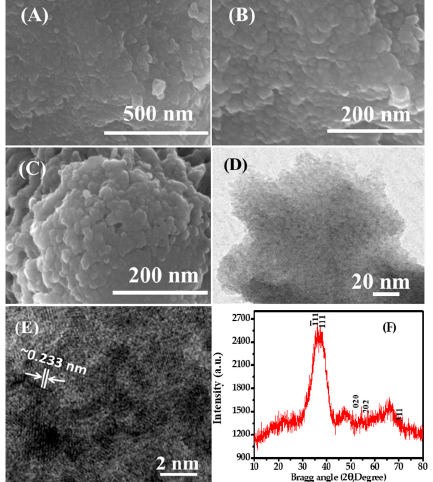
Figure 1. Field emission scanning electron microscopy (FE-SEM) images of copper oxide nanoparticles (CuO NPs): ( A ) NPs at low magnification and ( B ) high magnification; ( C ) After the adsorption of NPs; ( D ) TEM images of CuO NPs at low magnification; ( E ) HR-TEM images of NPs with lattice fringes about ~0.233 nm apart and showing the “d” value of the (111) of CuO NPs; ( F ) X-ray diffraction pattern of grown copper oxide